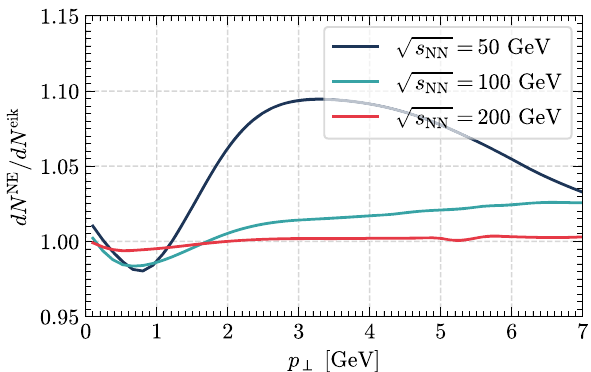
Fig. 3 Ratio of the non-eikonal single inclusive gluon spectrum, Eq. (4.6), to the eikonal result ( (cid:6) = 0) as a function of gluon trans- verse momentum, p ⊥ , for three values of the center-of-mass energy per nucleon and for η = 0